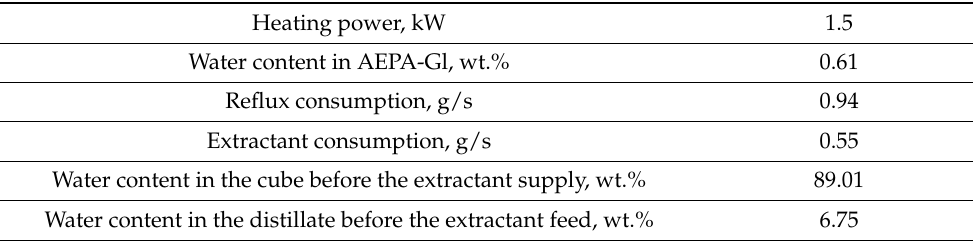
Table 5. Results on the experimental distillation